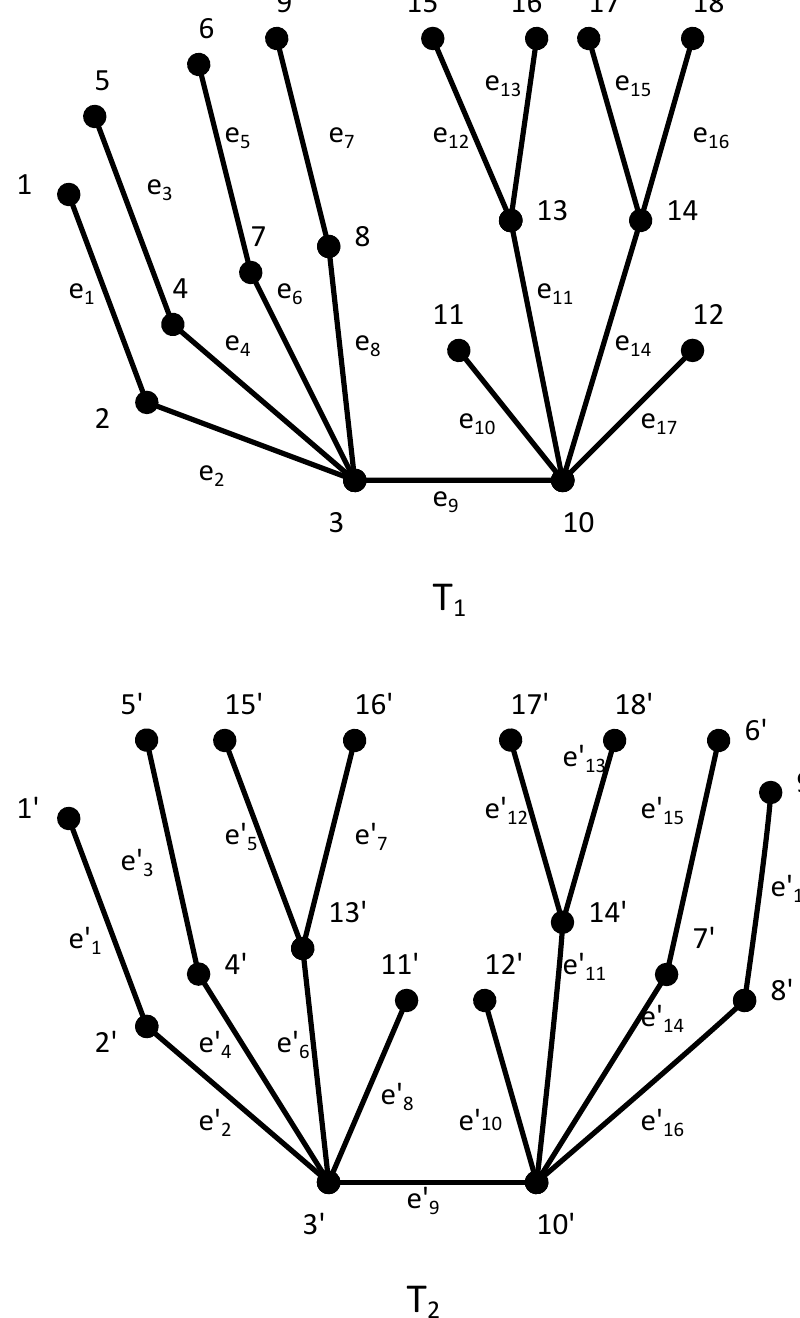
Figure 1: Slater’s minimal pair of non-isomorphic trees with the same Randi´c-table.